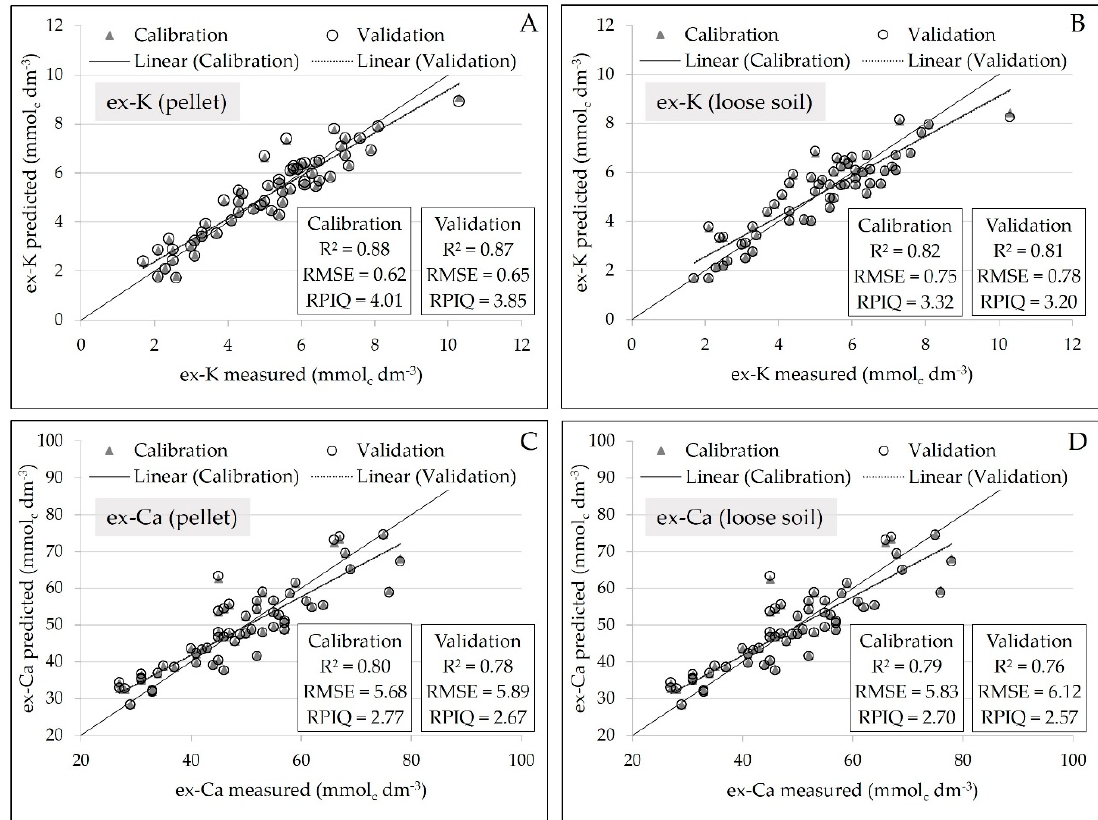
Figure 6. Scatter plots of measured versus predicted ex ‐ K, for the pellets and loose soil ( A and B , respectively), and of measured versus predicted ex ‐ Ca, for the pellets and loose soil ( C and D , respectively). Models were obtained using simple linear regressions with the K α emission lines of each element (n = 58) and the validation was performed by “leave ‐ one ‐ out” full cross ‐ validation.